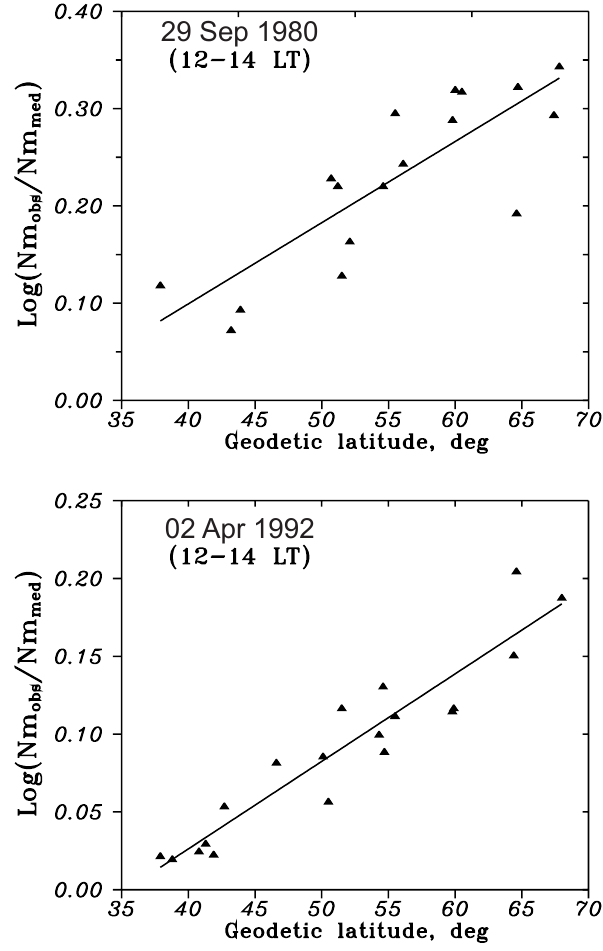
Fig. 6. Latitudinal variation for the amplitude of quiet-time positive NmF2 deviations observed in the European sector on 29 Sep 1980 and 02 Apr 1992. Mostly European ionosonde stations are used to derive the